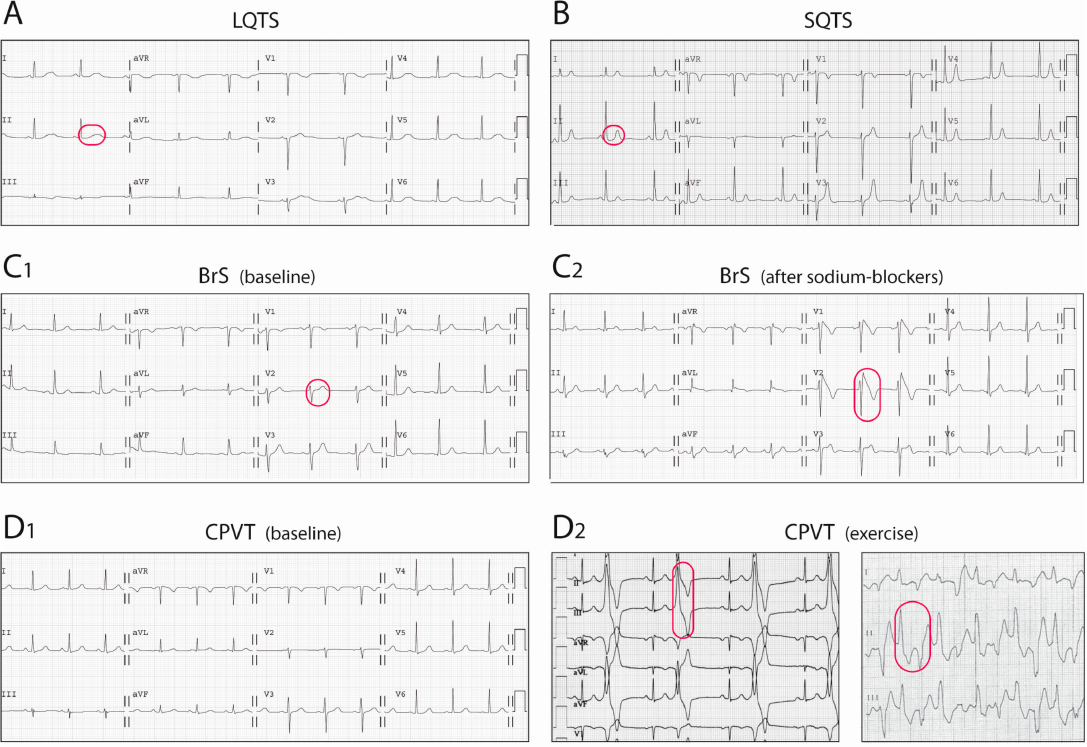
Figure 2. Electrocardiographic findings in the four primary electrical disorders or channelopathies. ( A ) LQTS, with prolonged QT interval; ( B ) SQTS, with shortened QT interval; ( C ) BrS. In this case, ECG at baseline was normal (C1), but the typical pattern, with ST-segment elevation in right precordial leads, was unmasked after a provocative test with sodium-blockers (D2); ( D ) CPVT. ECG is normal at baseline (D1), but premature ventricular complexes and occurrence of bidirectional tachycardia appear with exercise (D2). Characteristic ECG features of each disorder are circled in